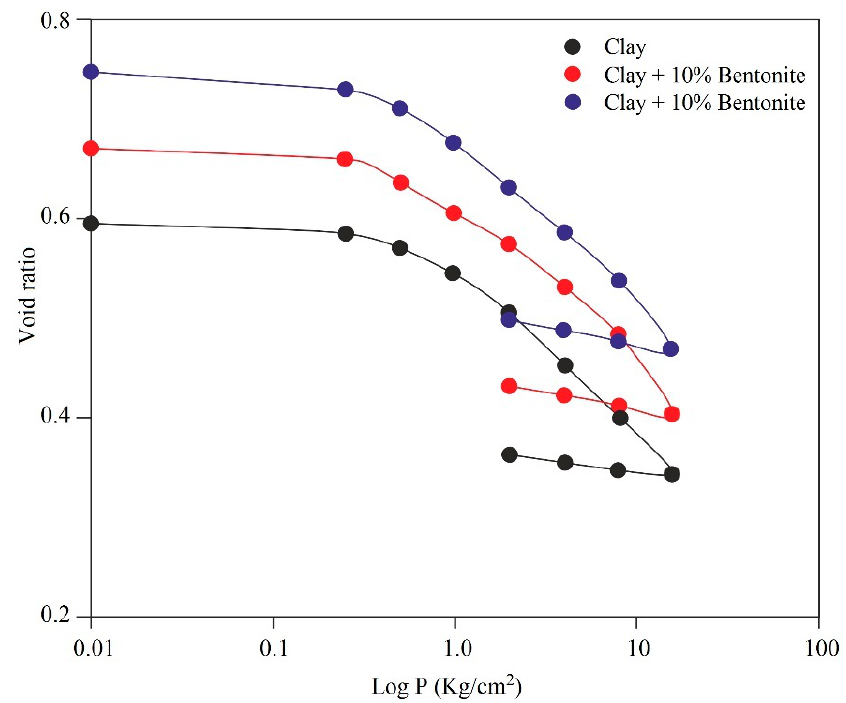
Figure 5. Diagram of the swelling and consolidation status for different samples.